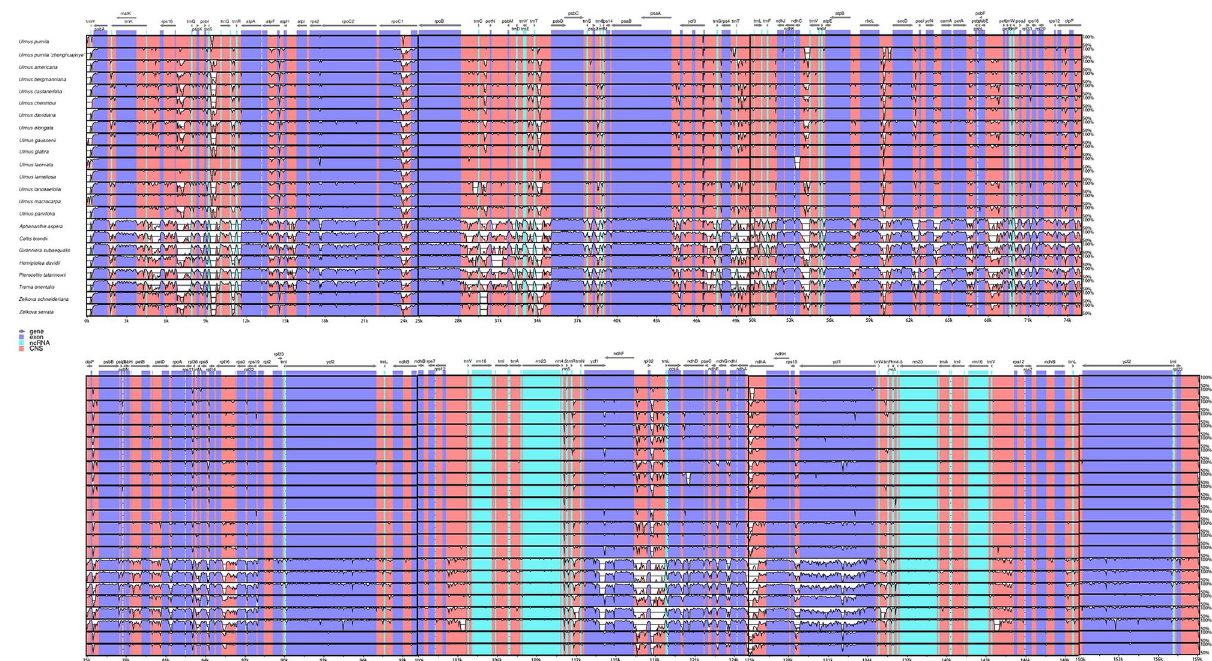
Figure 8. Sequence identity plots of the 23 Ulmaceae species genomes generated using mVISTA, taking the annotation of U. pumila as a reference. Grey arrows above the alignment indicate the orientation of genes. Blue bars represent exons, pink ones represent non-coding sequences (CNS). X-scale axis represents the genome coordinate positions, Y-scale axis represents the percent identity within